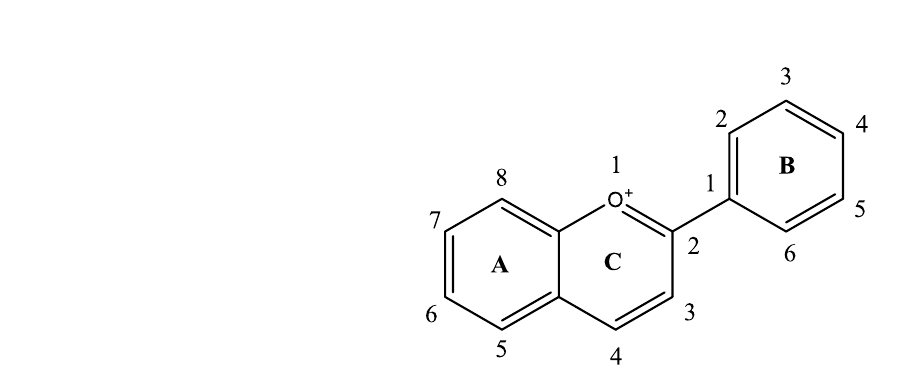
Figure 1. The structure of Flavylium cation [3]